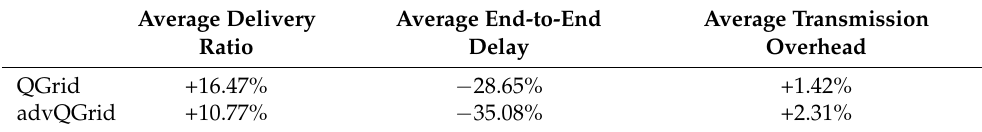
Figure 17. Simulation comparison among different routing protocols vs. different message times. Table 12. Performance improvement of SD-QGrid compared to routing protocols with message time.